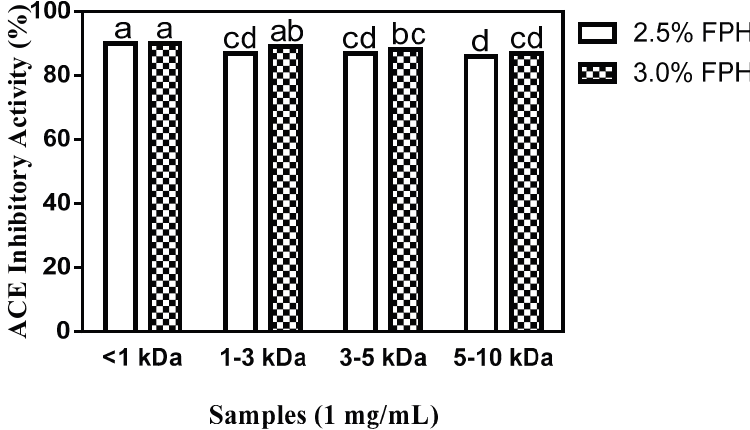
Figure 3. Percentage (mean ± standard error) of ACE-inhibitory activity of flaxseed protein hydrolysate (FPH) membrane ultrafiltration fractions after hydrolysis of isolated flaxseed proteins with 2.5% or 3.0% thermoase GL-30 and passing the hydrolysates through molecular weight cut-offs (MWCOs) of 1, 3, 5 and 10 kDa. Bars with different letters have mean values that are significantly different ( p <